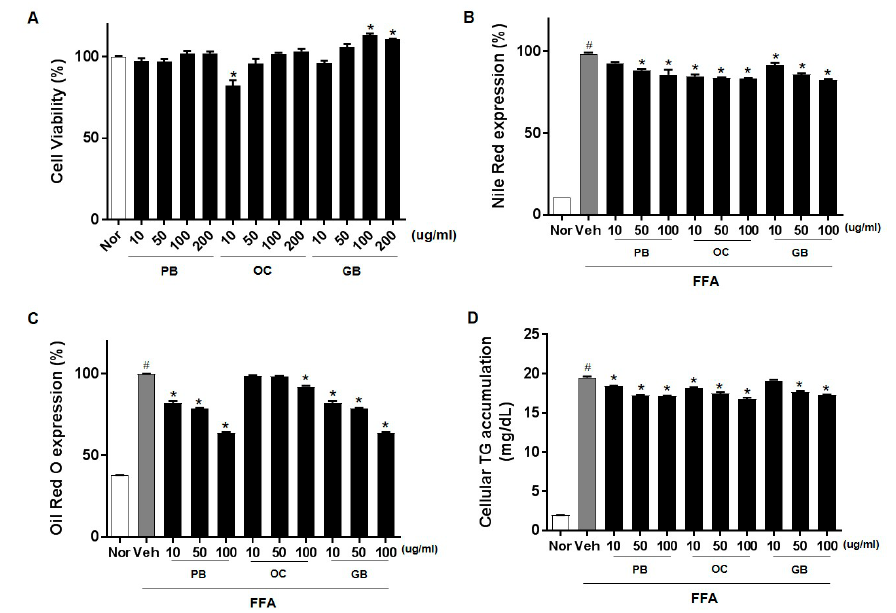
Figure 1. Inhibition of free fatty acids (FFA)-induced lipid accumulation by Protaetia brevitarsis seulensis (PB), Oxya chinensis sinuosa (OC), and Gryllus bimaculatus (GB) extracts in HepG2 cells. HepG2 cells were cultured with 0.1% bovine serum albumin (BSA, control), 1 mM FFA mixture, or 1 mM FFA and PB, OC, and GB extracts (10, 50, and 100 μ g/mL) for 24 h. ( A ) Cell viability after 24 h of treatment with PB, OC, and GB extracts. After 24 h, intracellular lipid accumulation was assessed by Nile red staining ( B ) and Oil Red O staining ( C ). The data are representative of three independent experiments. ( D ) Intracellular triglyceride (TG) content was measured, and absorbance readings were normalized to protein concentrations. Nor, normal. The data represent the mean ± SEM of at least three individual experiments; # p < 0.05 compared with the control group; * p < 0.05 versus FFA